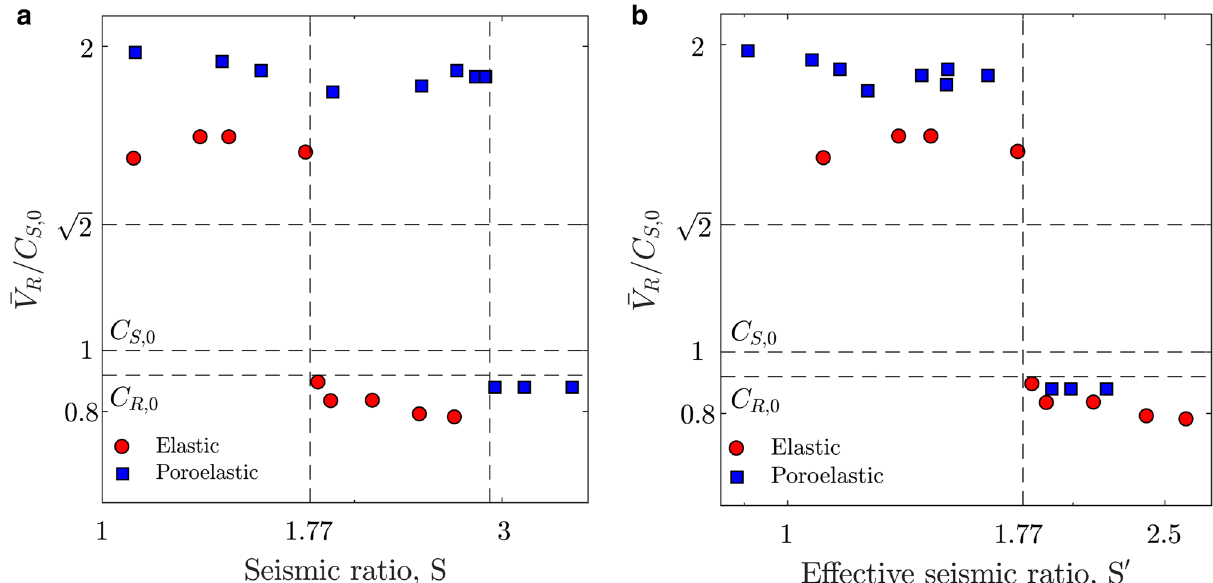
Figure 6. Interpretation of supershear ruptures in poroelastic media through an effective seismic ratio. We simulate ruptures in a slip-weakening, strike-slip fault model (see Supplementary Material, Section 2, for the model setup). ( a ) We perform simulations with several dynamic friction coefficients, and verify that the transition for ruptures in elastic media occurs at the Andrews seismic ratio of 1.77 (red circles), while the transition for poroelastic media ( α B 0.95) occurs at a significantly larger value (blue squares). ( b ) By = expressing the seismic ratio using effective , rather than total normal stresses (see Supplementary Material, Section 4, for the calculation of the effective residual strength), we recover the transition at an effective seismic ratio S ′ ≈